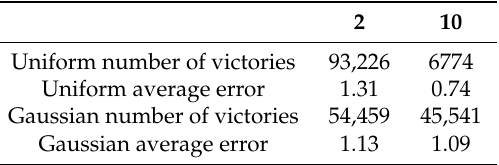
Table 5. Number of times each value of k in {2,10} produces minimal error and average error values, over 100,000 items generated according to both generative models. For k = 10, we only permitted scores between 3 and 7 (inclusive). If a score was below 3, we set it to be 3, and above 7 to 7.